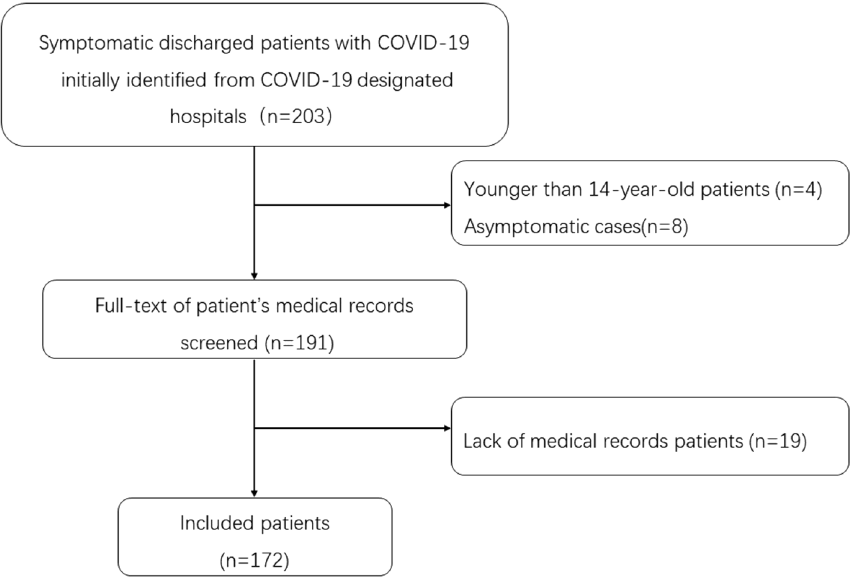
Figure 1. Flowchart of patient inclusion and exclusion in this